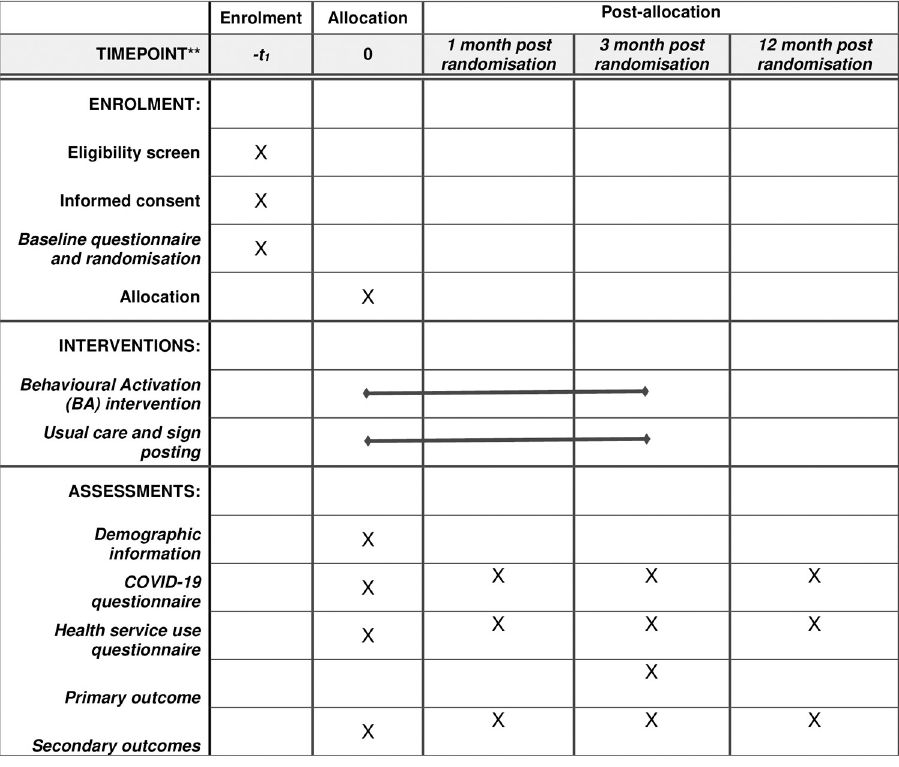
Fig 1. SPIRIT schedule of enrollment, interventions, and